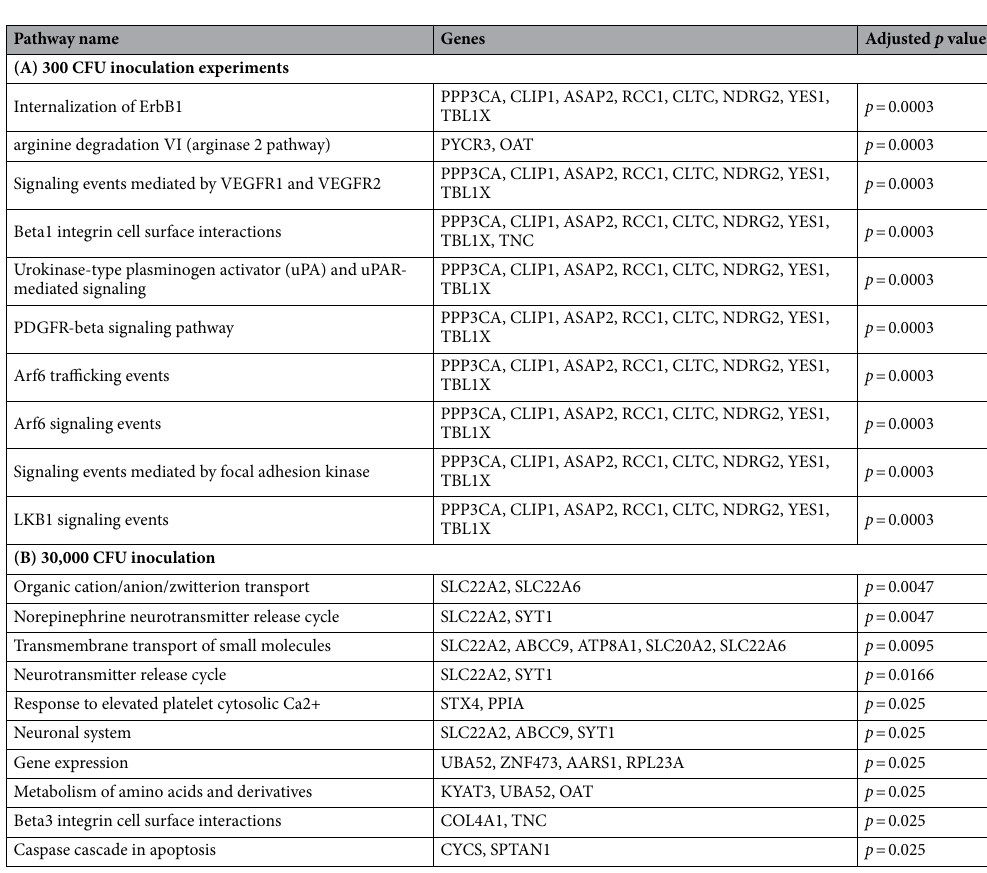
Table 4. Pathway commons analysis. Tables report the top 10 pathways over-represented in 300 (A) and 30,000 (B) CFU inoculation